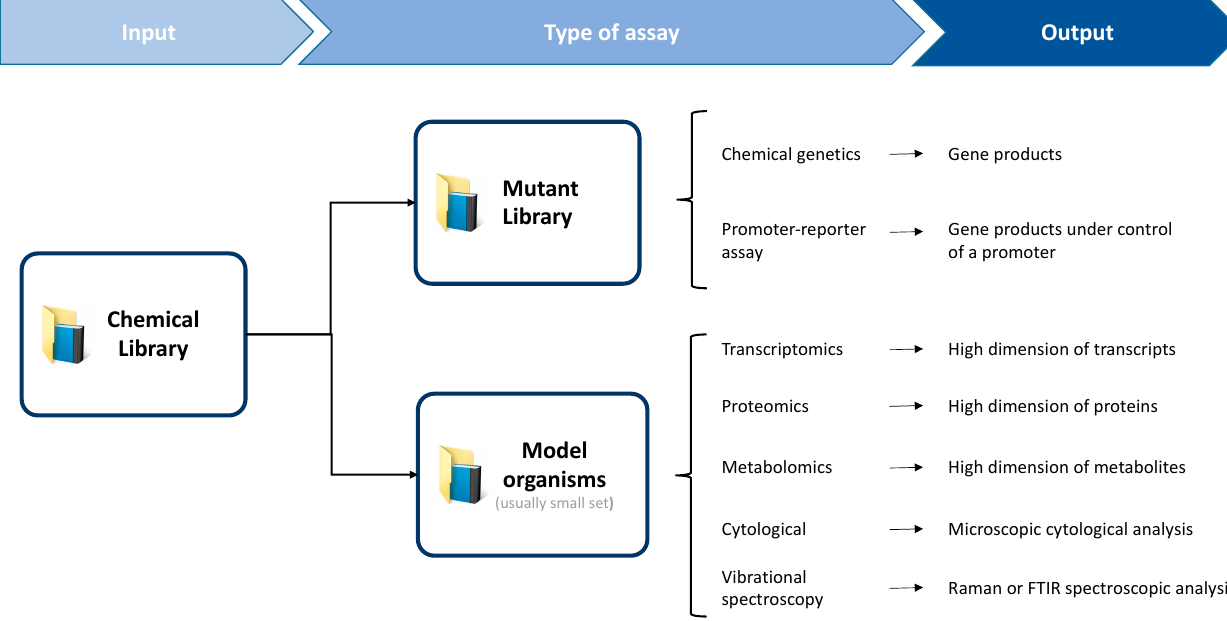
Figure 3. Two commonly employed approaches to predict antibiotic MOA. These are typically based on the high-throughput screening of a chemical library against a high dimension mutant bacteria library, or against a smaller set of model bacteria. Accordingly, different types of assays are applied, which generate specific outputs that are often complementary.